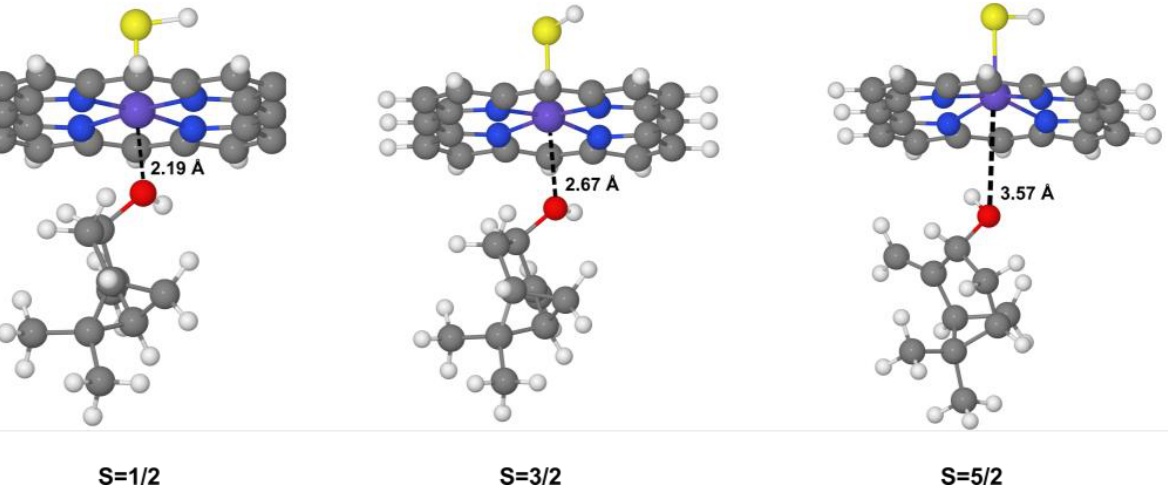
Figure 5. Optimized structures for delta site cis-(R) hydroxylation products of β -pinene in doublet, quartet, and sextet states. Interaction distances are provided in angstroms.